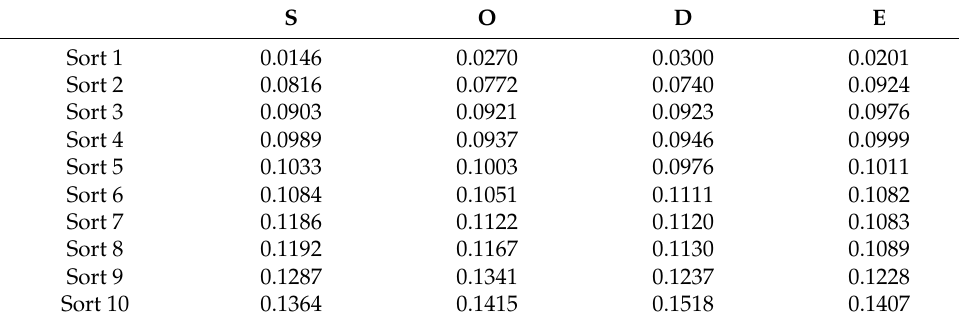
Table 4. The Matrix β (sorted results of matrix A ).